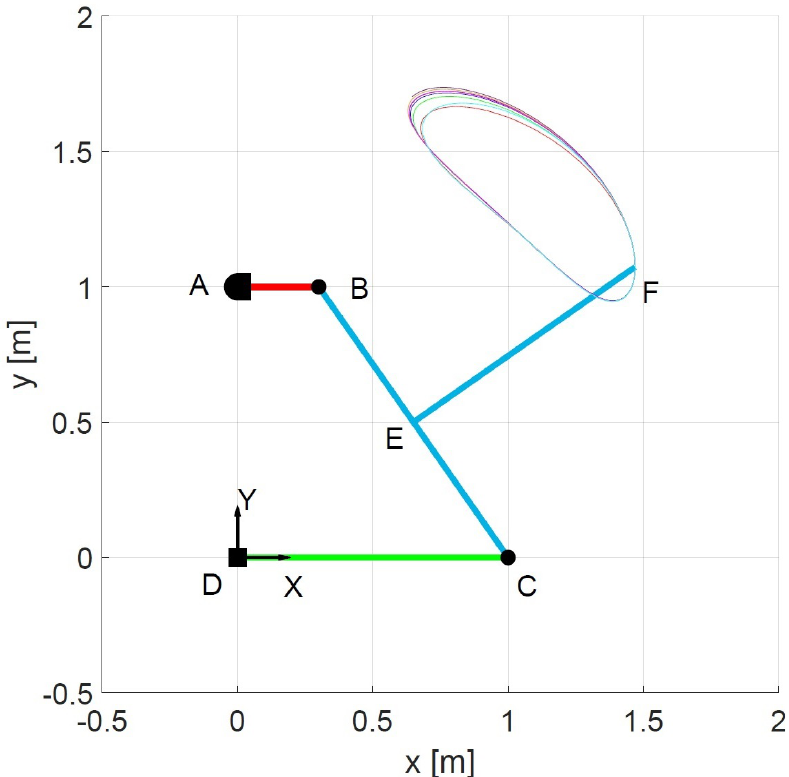
Figure 8. Trajectory of point F after a complete turn of the crank AB and under different load cases.